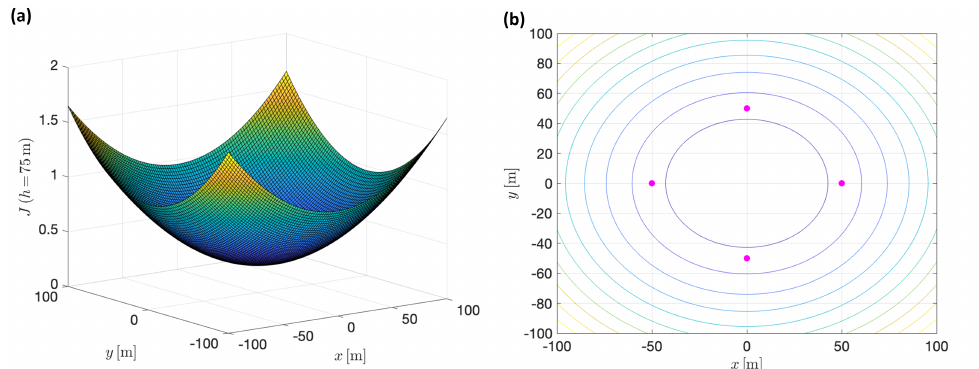
Figure 10. ( a ) Particularizing the hypersurface J for altitude h = 75[m]. ( b ) Corresponding level curves. Magenta dots represent targets’